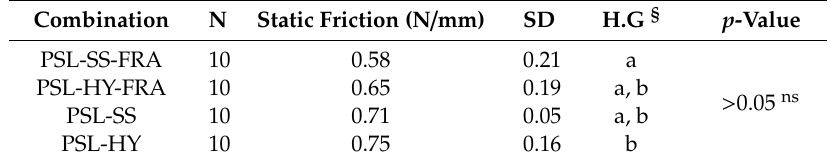
Table3. Staticfrictionvaluesinmetallicpassiveself-ligatingbrackets(PSL).Thelettersshowsignificance statistical di ff erences.